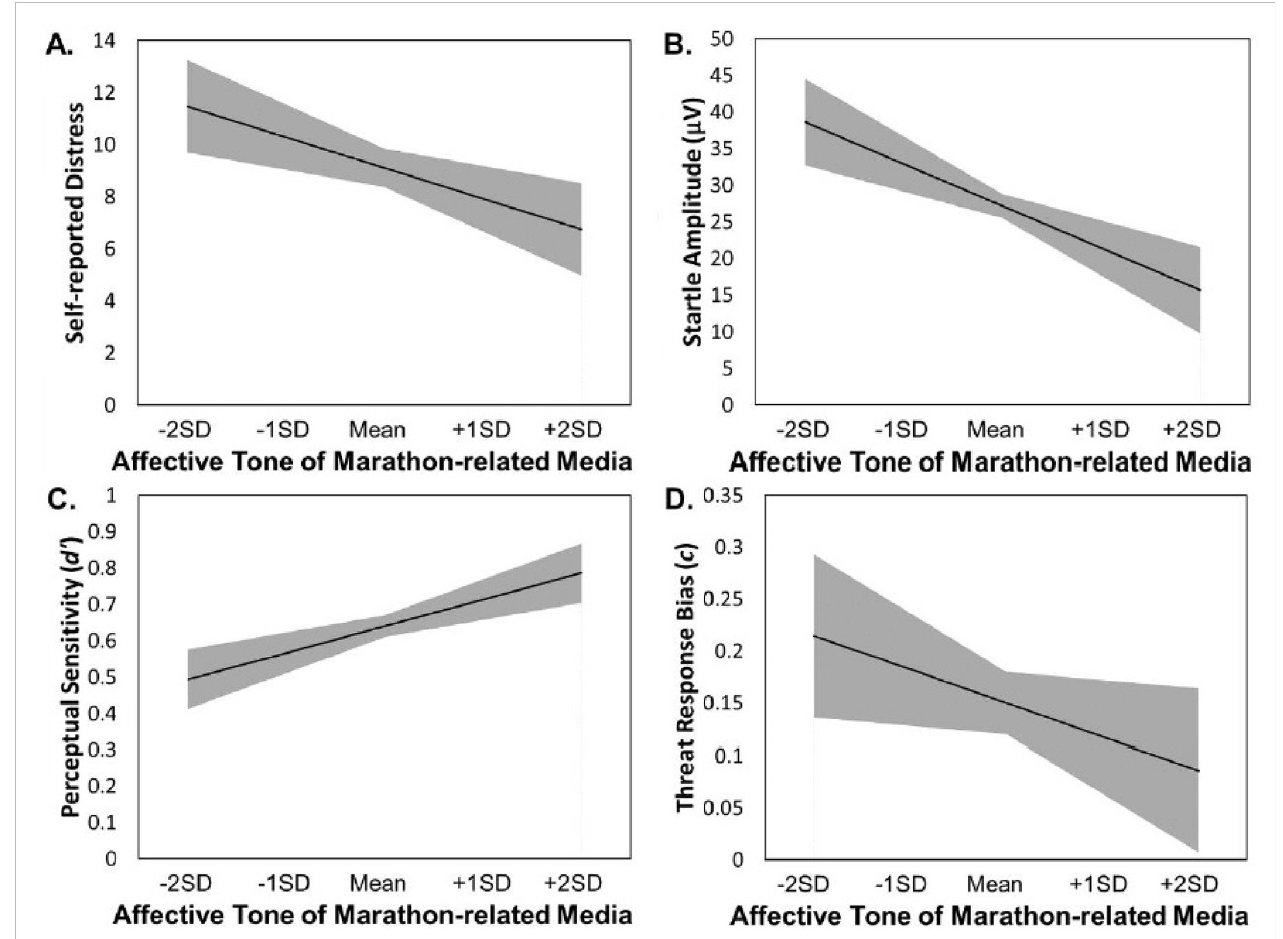
Fig 1. Simple slopes representation of models predicting changes in distress (Panel A), startle reactivity (Panel B), perceptual sensitivity (Panel C), and threat response bias (Panel D) by changes in the affective tone of recent marathon-related coverage. Affective tone of recent marathon-related media coverage was calculated to be time-locked for each participant at each Wave to include only media coverage from the two weeks prior to that participant’s laboratory visit. Model slopes are represented by a black line, with ± 1 standard error of the slope and intercept for each model shown as a gray-shaded area. SD stands for standard deviation. The model for perceptual sensitivity (Panel C) is plotted at the within-person mean for threat response bias, and the model for threat response bias (Panel D) is plotted at the within-person mean for perceptual sensitivity.